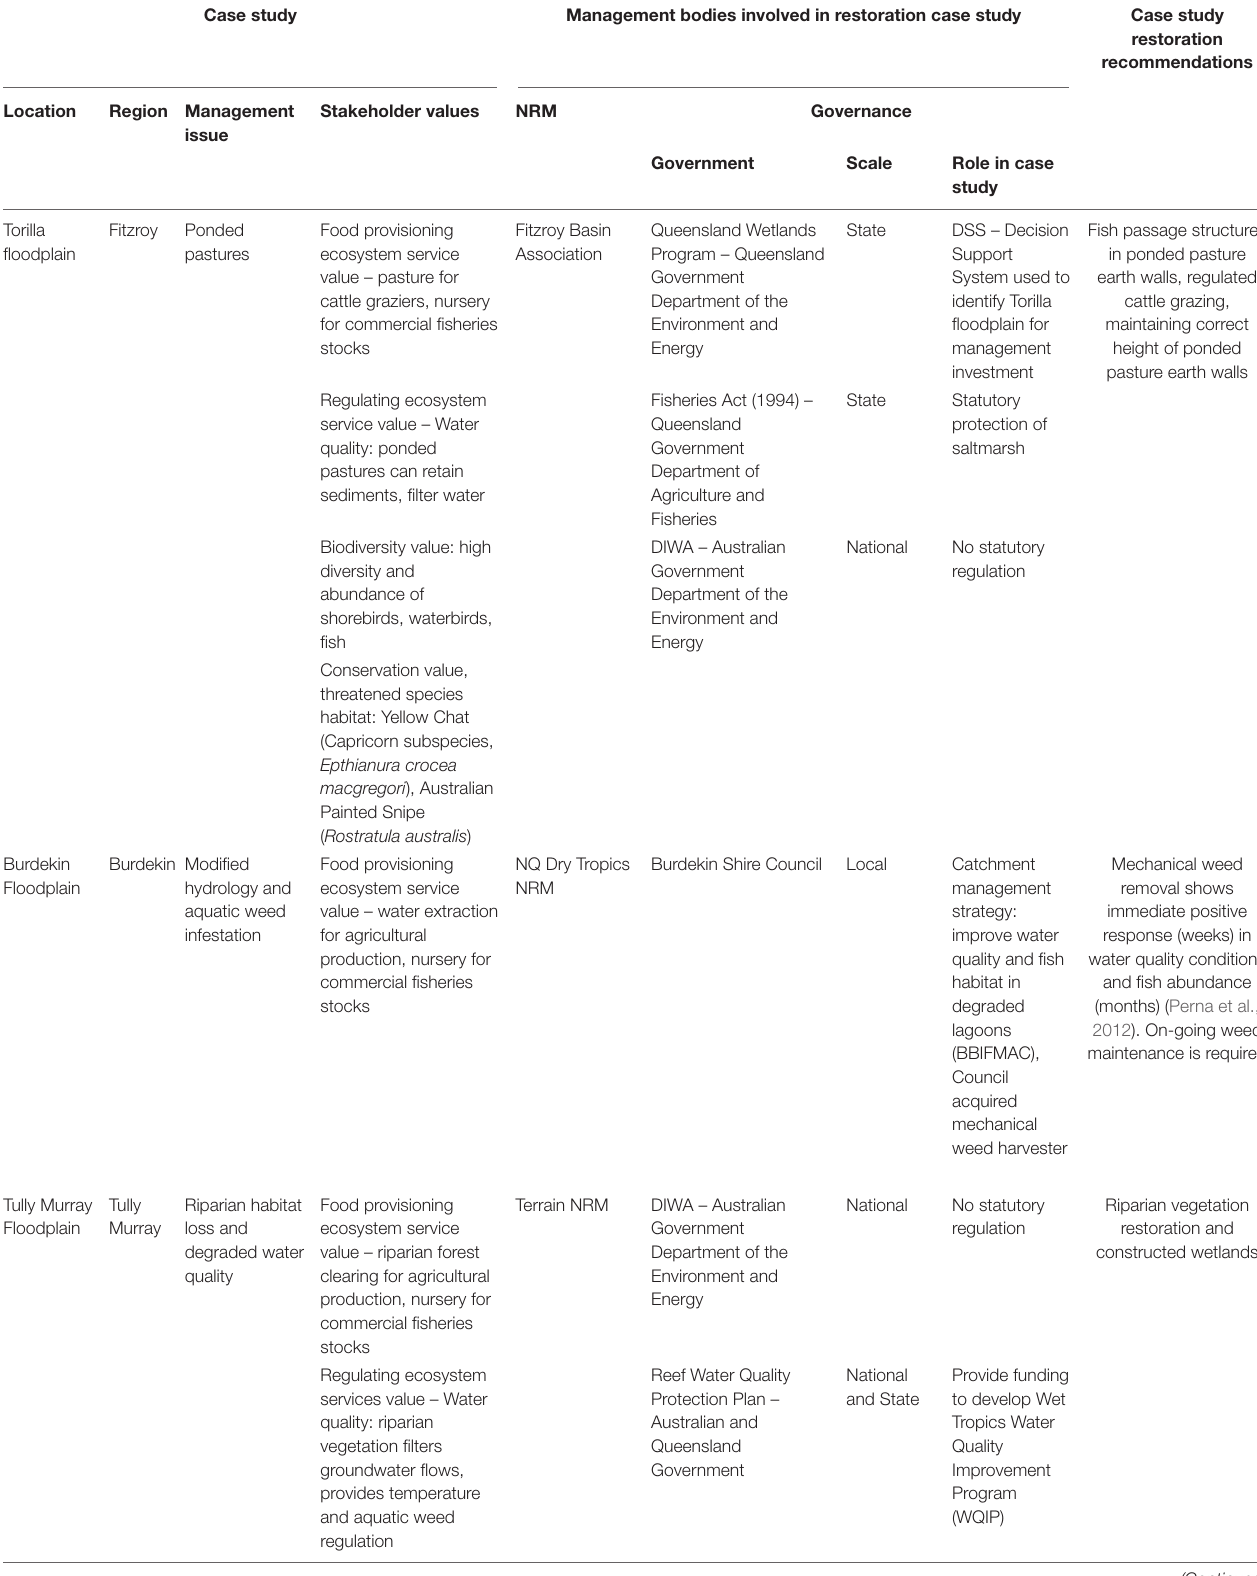
TABLE 2 | Overview of stakeholder values and management bodies involved in three coastal wetland restoration case studies across catchments of the Great Barrier